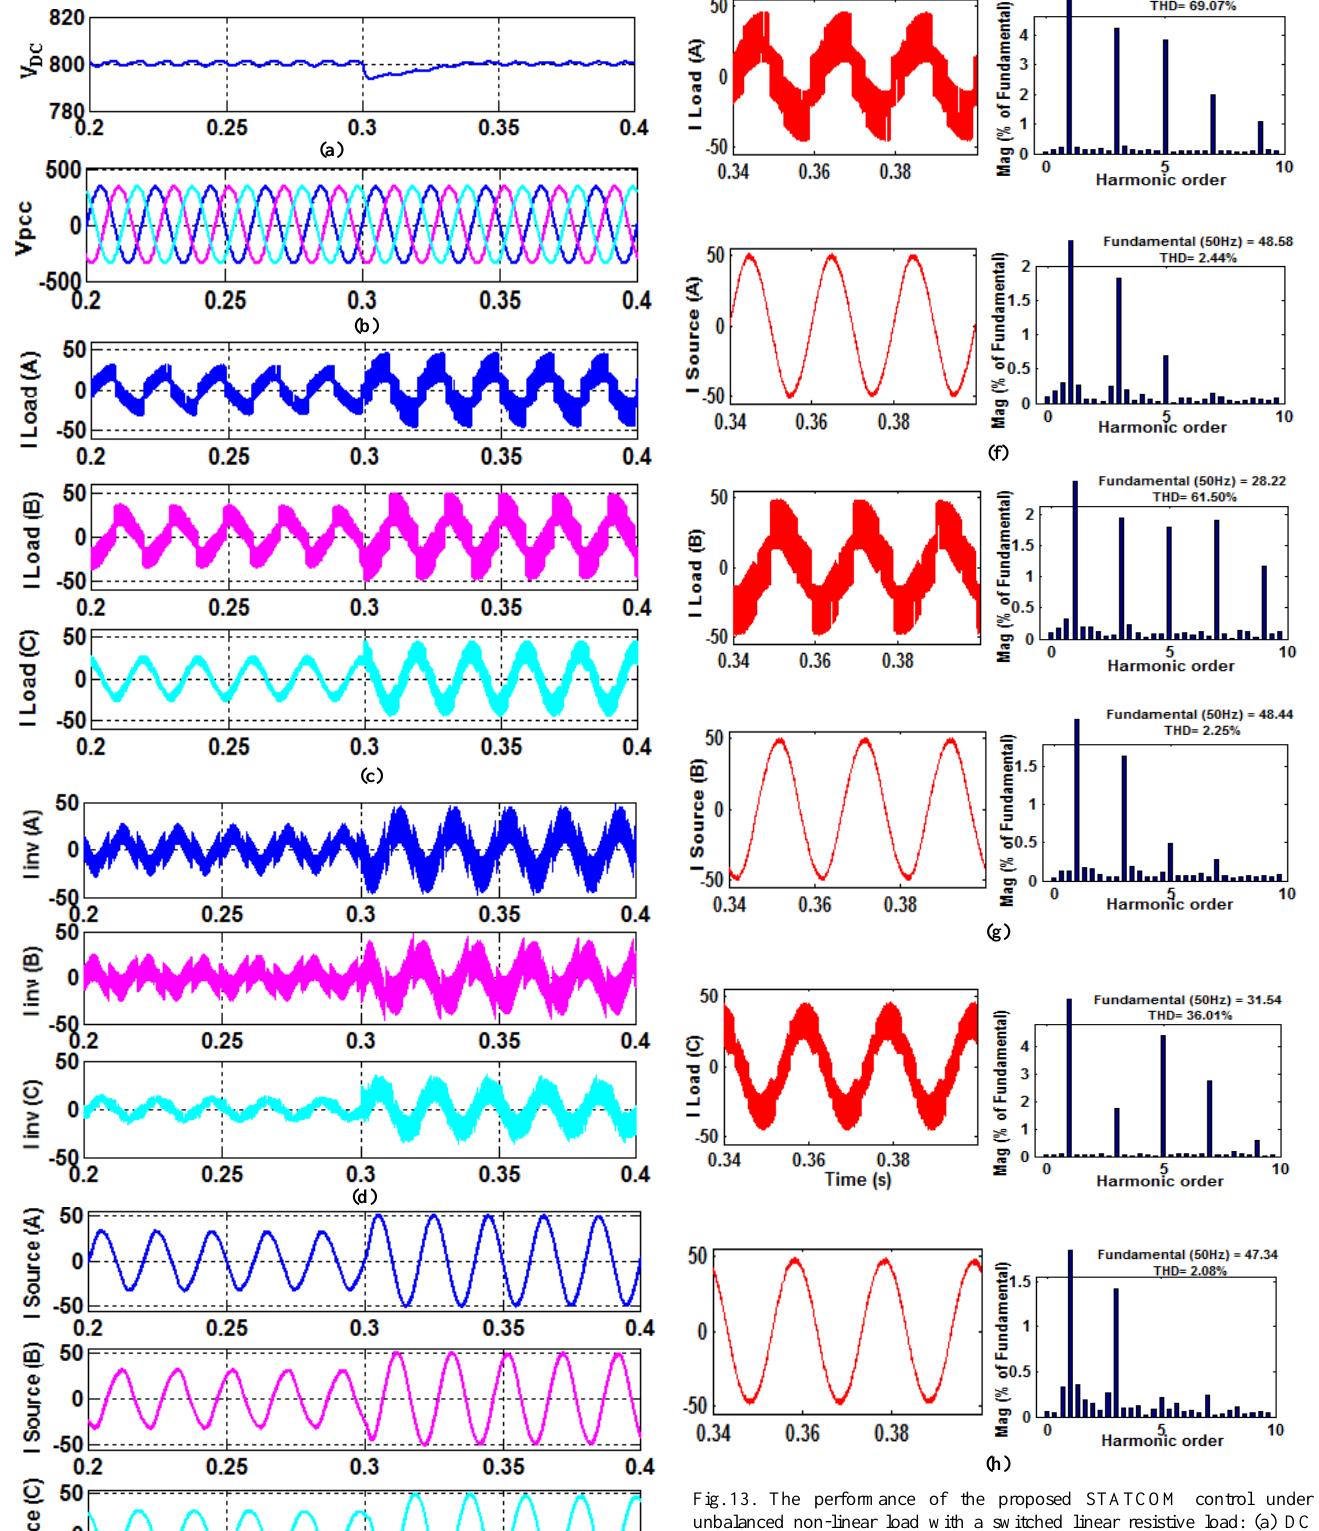
Fig. 13. The performance of the proposed STATCOM control under unbalanced non-linear load with a switched linear resistive load: (a) DC capacitor voltage; (b) voltage at PCC; (c) load current profiles separately for all three phases; (d) STATCOM (inverter) compensating current profiles separately for all three phases; (e) compensated source current profiles separately for all three phases. Harmonic spectra of load currents and compensated source currents for (f) phase a; (g) phase b; (h) phase